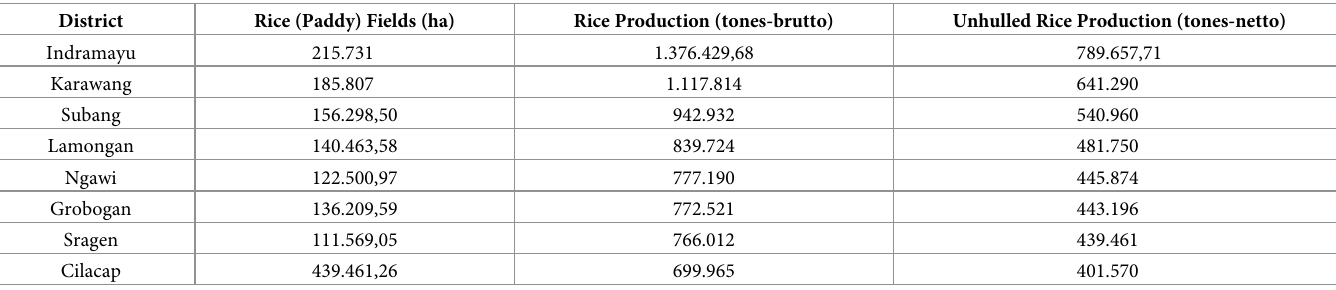
Table 1. The rice fields and yields of the eight districts in 2019 [34].